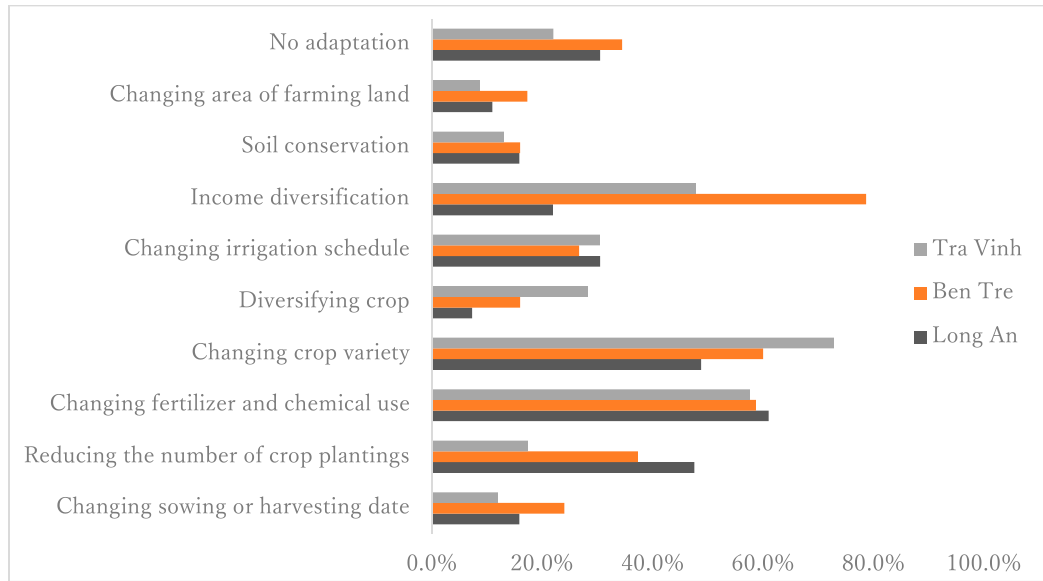
Figure 2. Adaptation practices implemented by local rice farmers.